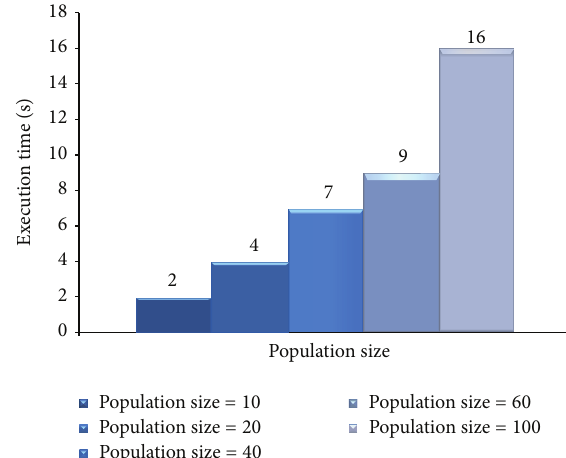
Figure 12: Average fitness value of different populations during generations.